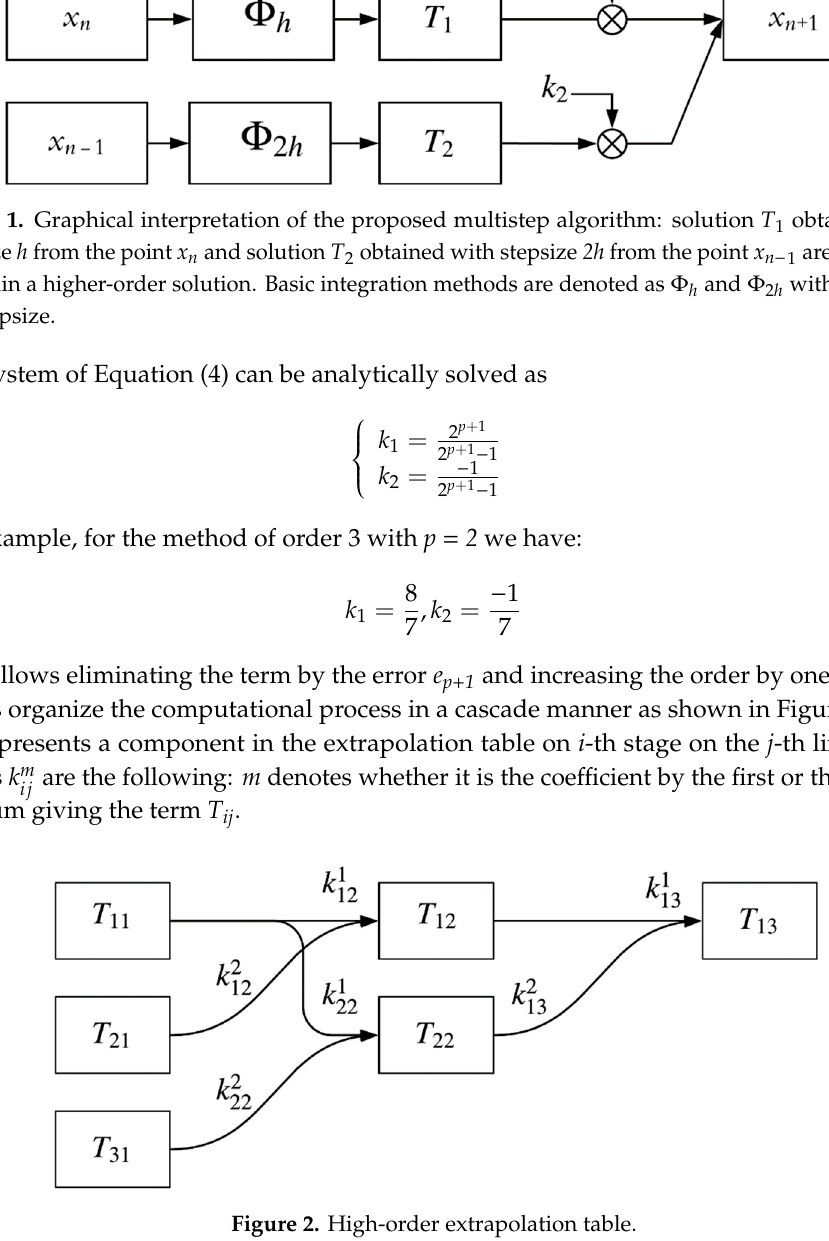
Figure 2. High-order extrapolation table.